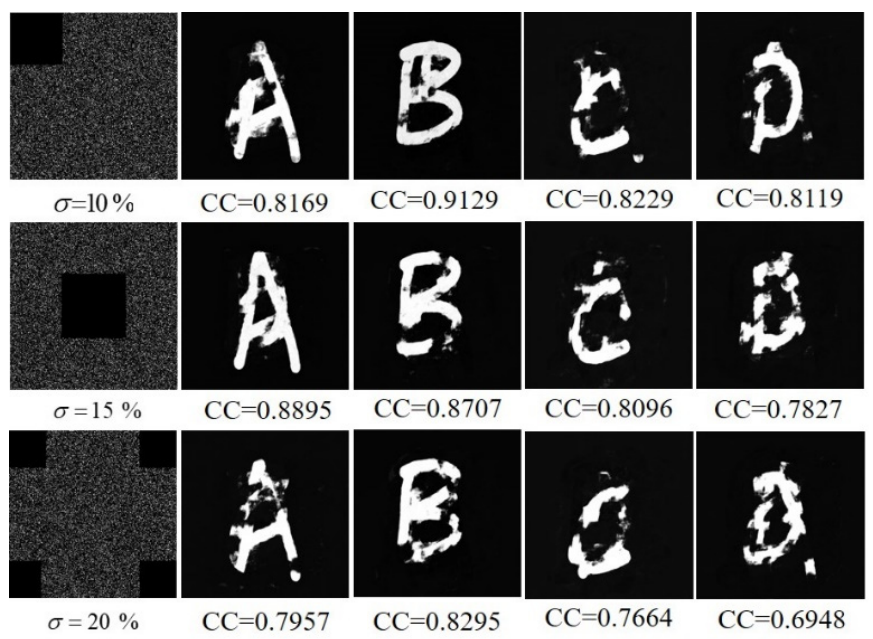
Figure 12. Decryption results after different degrees of occlusion attacks on ciphertext.